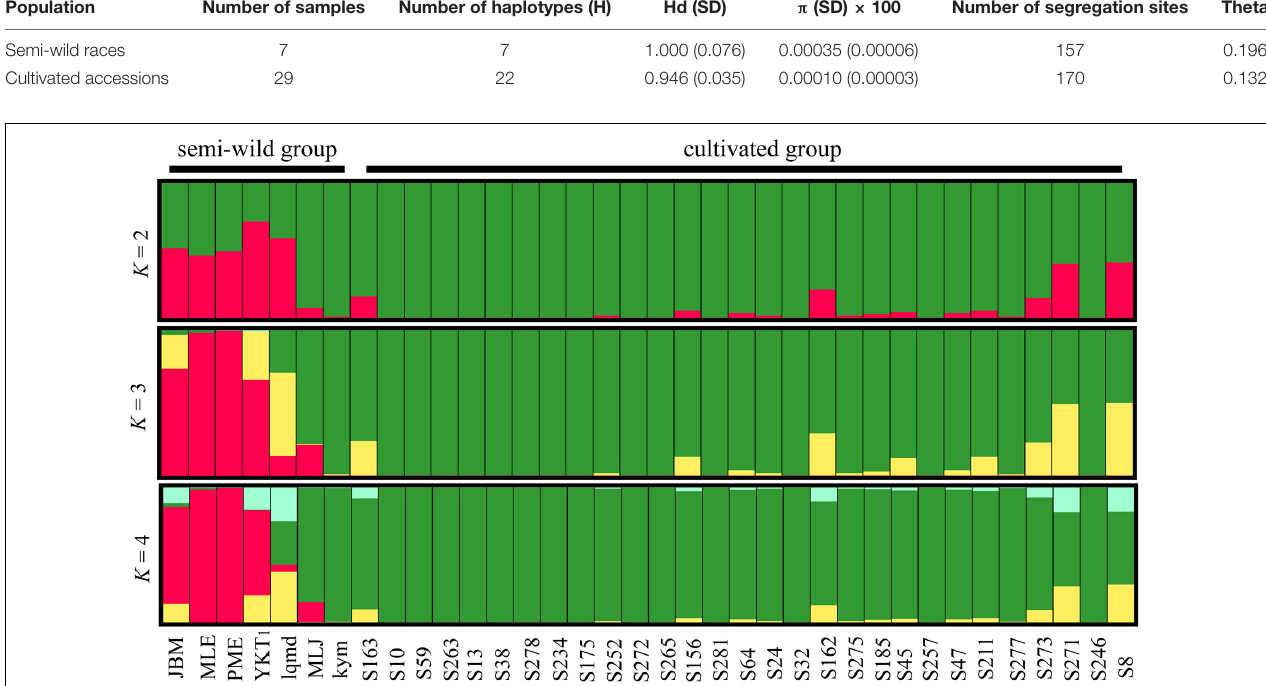
FIGURE 4 | Bayesian clustering results obtained for cotton accessions by STRUCTURE analysis. Each individual is represented by a vertical bar, which is partitioned into K colored segments showing the individual’s probability of belonging to the group with that